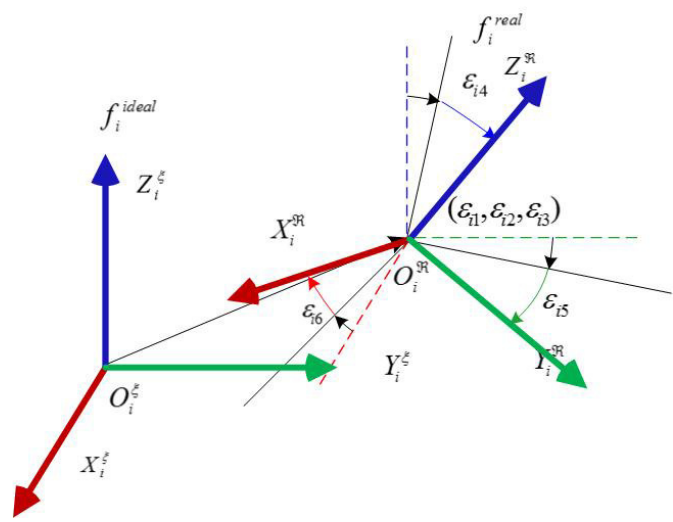
Figure 2. Definition of the generalized geometric error parameter for the i th